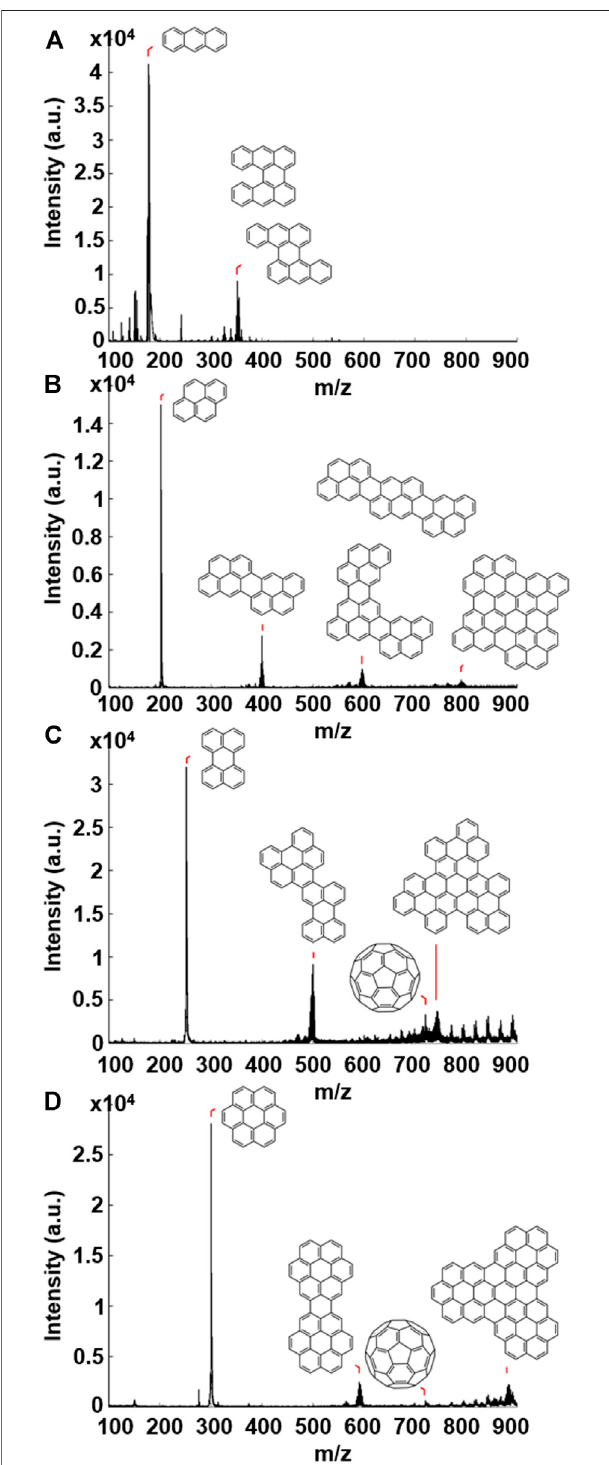
FIGURE 2 | Mass spectra resulting from UV laser irradiation at high laser fl uence ( ∼ 2,600 mW cm − 2 ) of; (A) anthracene, (B) pyrene, (C) perylene and (D) coronene. Proposed structures of the species present are illustrated above the corresponding m/z peaks.